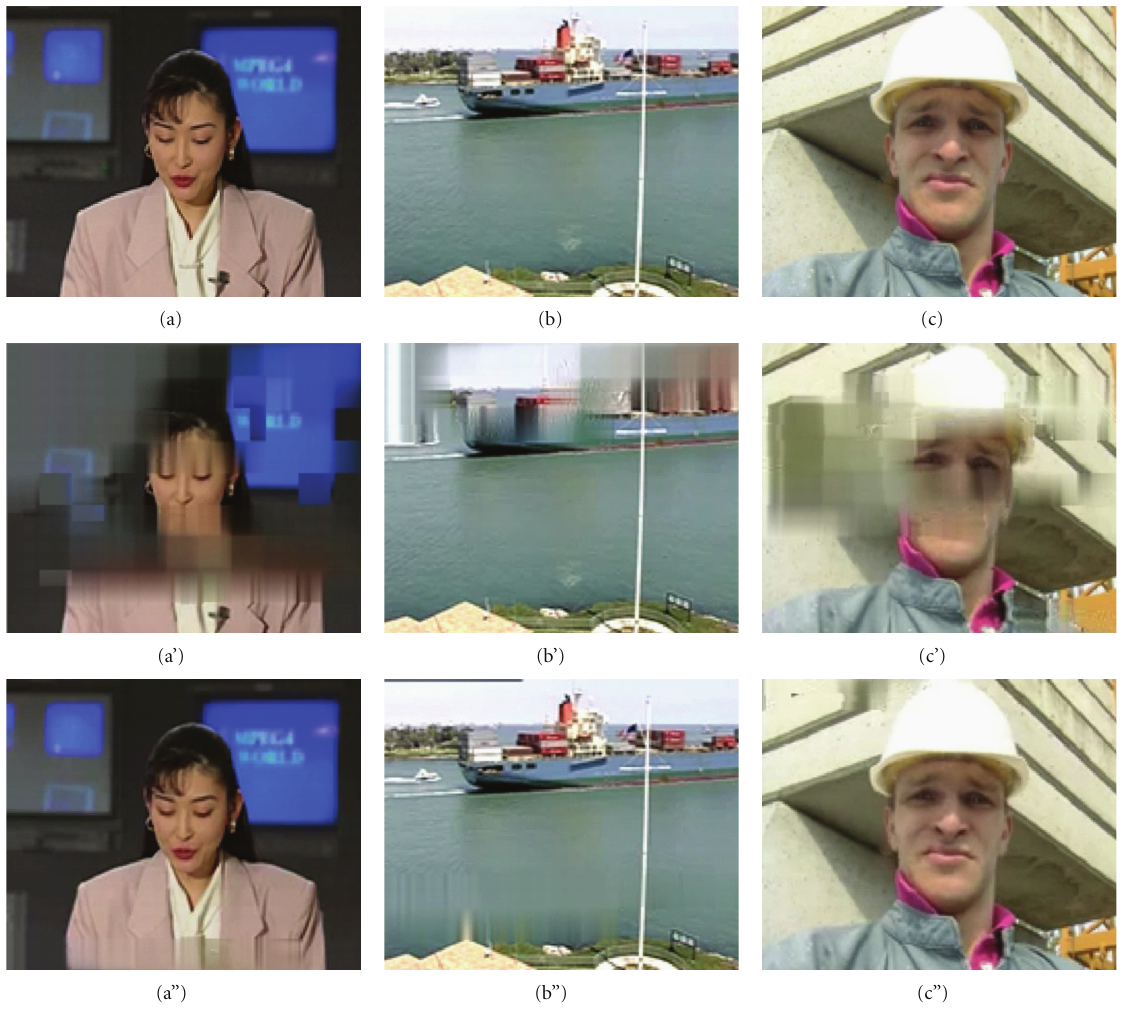
Figure 8: Subjective quality test for three test video